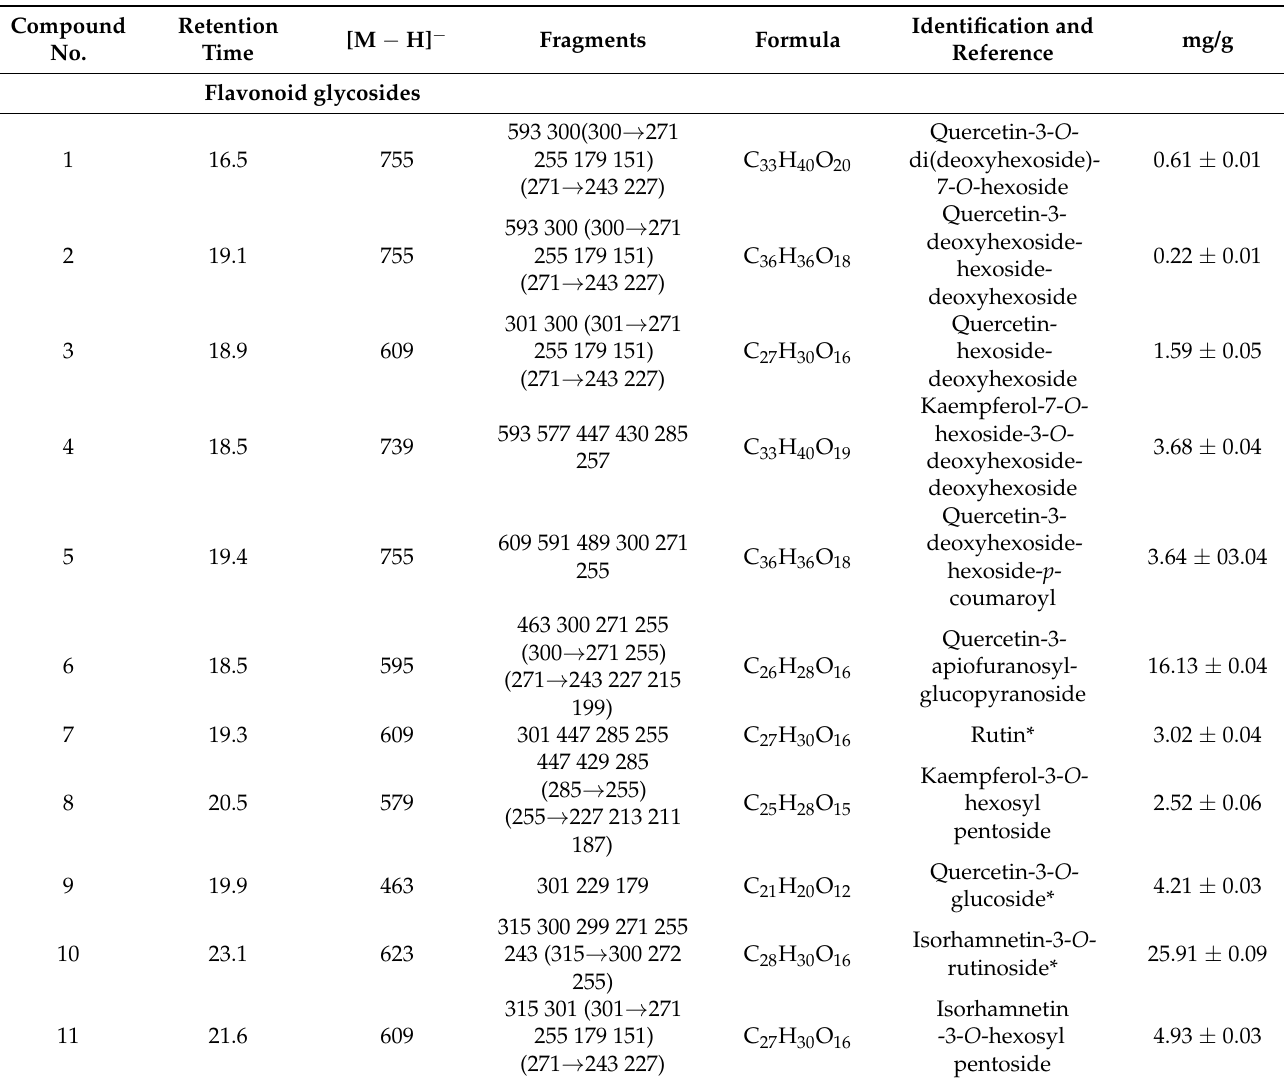
Figure 4. LC-DAD chromatogram (330 nm) showing the peak group assigned to small phenolics, flavonoids, and phe- nylpropanoid derivatives; exemplificative UV spectra of the peaks are included. Peaks numbers refer to Table 2.